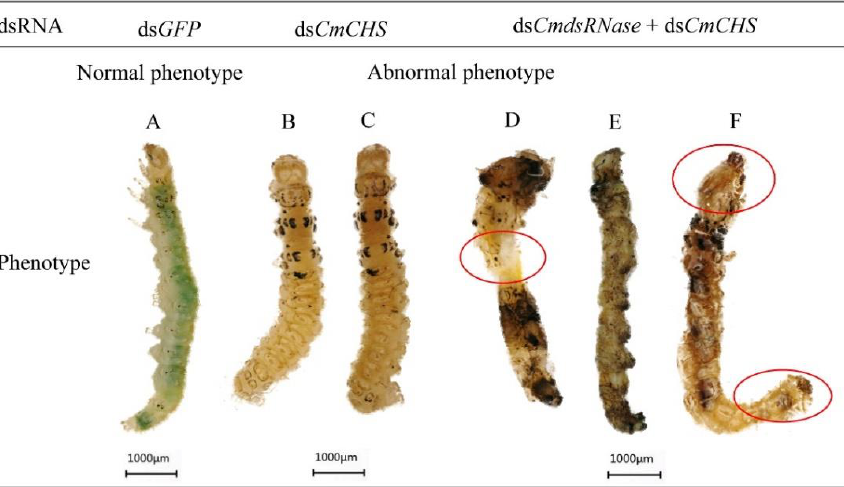
Figure 11. Abnormal morphology of C. medinalis larvae after dsRNA injection. ( A ) Phenotypes of larvae after ds GFP injection. ( B , C ) ds CmCHS -injected larvae. ( D – F ) Larvae injected with ds CmdsRNase + ds CmCHS . Red circles indicate the phenotypic changes in the larvae. Each scale bar represents 1000 µ